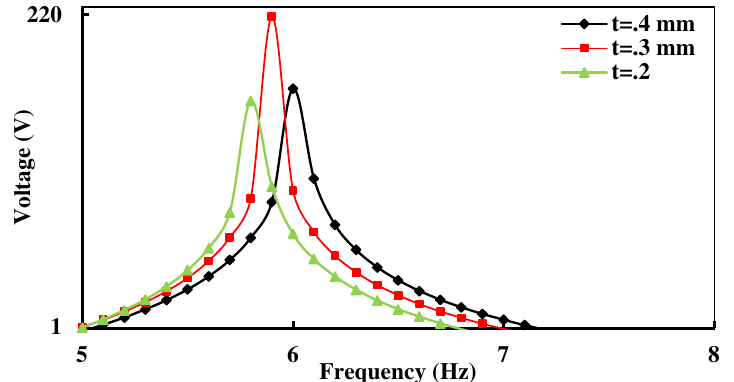
Figure 11. The effect of the PZT thickness on the output voltage and bandwidth natural frequency.